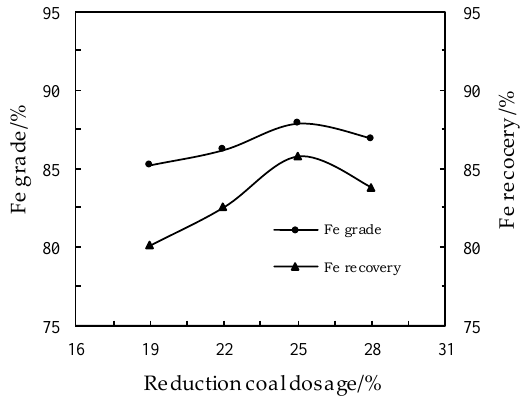
Figure 2. Effect of reduction coal dosage on the DR process.